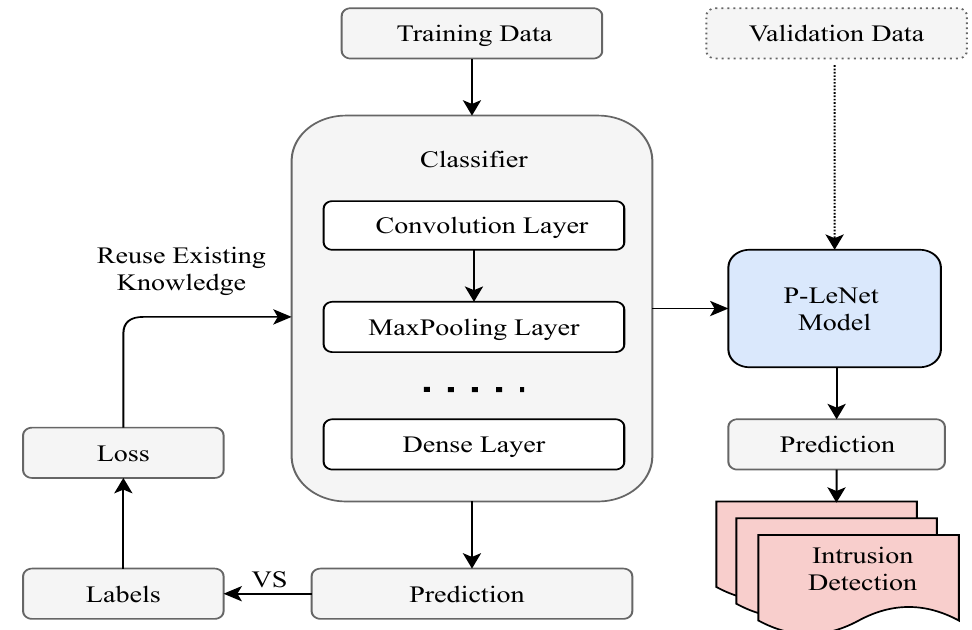
Figure 5. The block diagram of the proposed P-LeNet